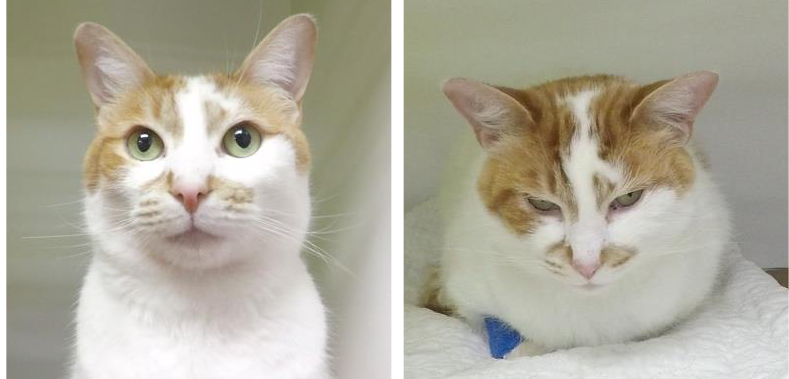
Figure 4. Example of changes in facial expressions in a cat from the control group before ( left ) and 0.5 h after ( right ) the end of general anesthesia with propofol and isoflurane. 0.5 h after ( right ) the end of general anesthesia with propofol and